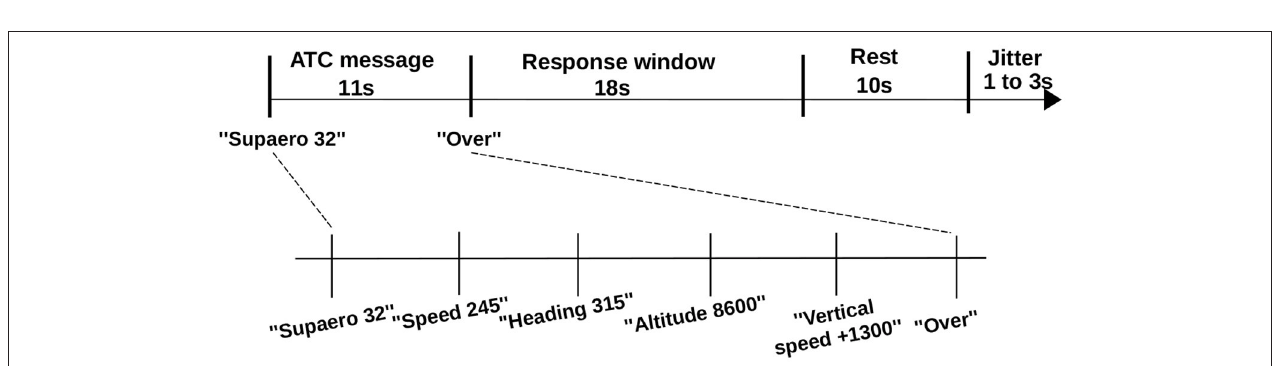
FIGURE 3 | ATC span task trial design (High Load